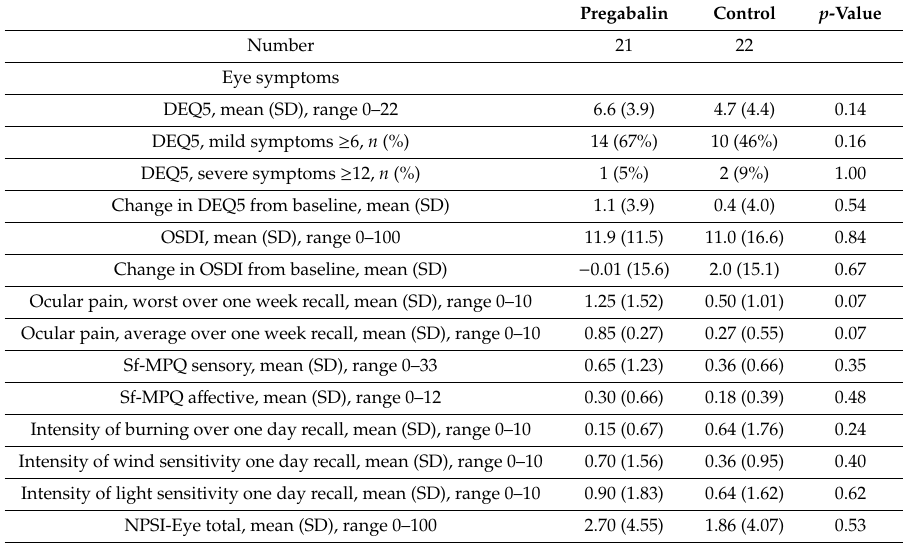
Table 2. Ocular symptoms at three months post-LASIK, by treatment assignment.